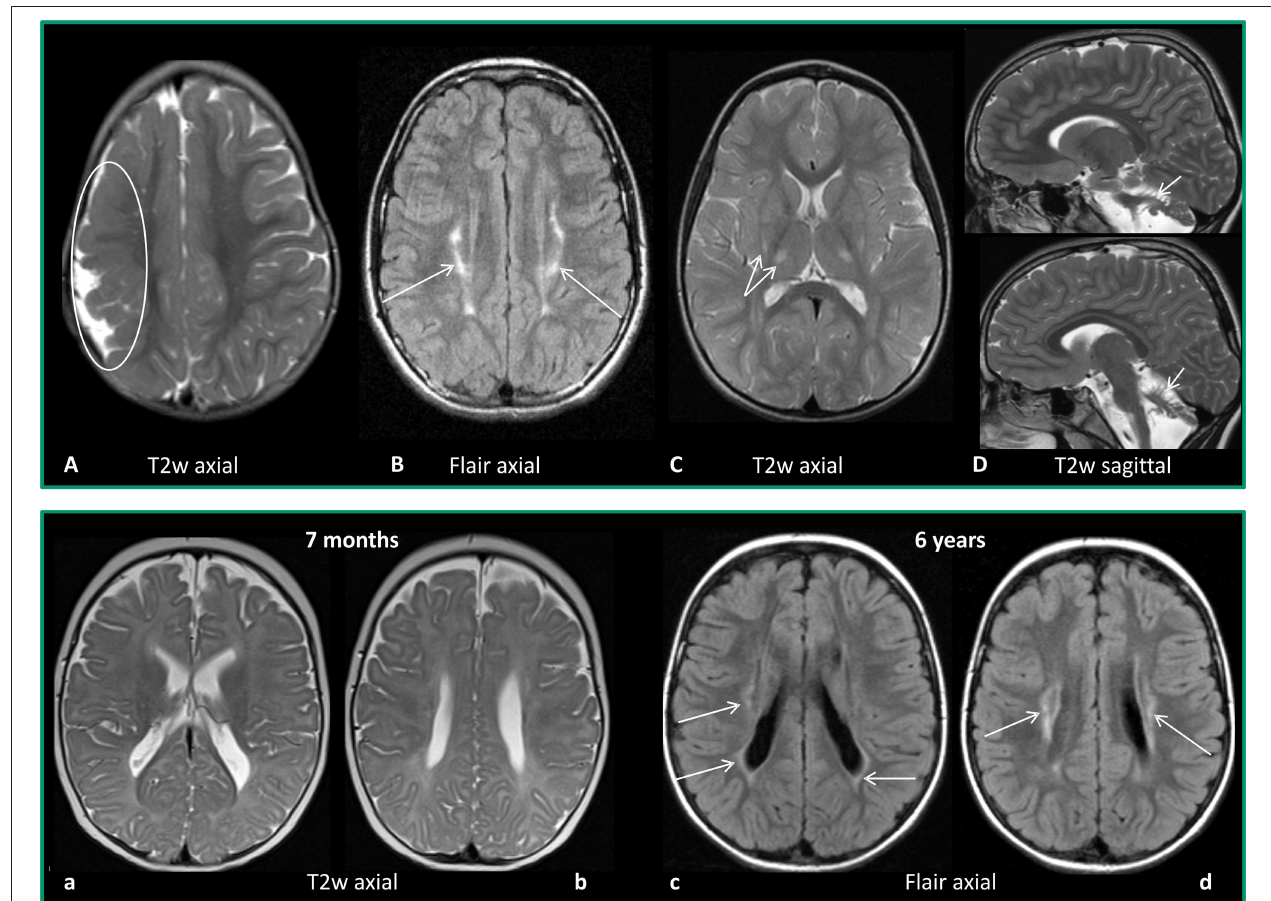
FIGURE 1 | Upper row: Examples for MRI patterns. (A) Maldevelopment: frontoparietal polymicrogyria right (encircled), 2 years old girl with US-CP left GMFCS I. (B) Predominant white matter injury: mild PVL (arrows), 12-year-old girl, preterm 32 weeks of gestation, BS-CP GMFCS I. (C) Predominant gray matter injury: mild basalganglia/thalamus lesions (double arrow), 3-year-old girl, placental ablation, dyskinetic CP GMFCS II. (D) Miscellaneous: cerebellar atrophy (arrows), 2-year-old boy, former preterm 26 weeks of gestation, ataxic CP, GMFCS I. Lower row: Example for difficulty of early diagnosis–PVL, former preterm, 32 weeks of gestation. (a,b) MRI at the age of 7 months: T2w axial images with no clear pathology. (c,d) MRI at the age of 6 years (BSCP, GMFCS III): axial FLAIR images reveal bilateral gliosis indicating PVL